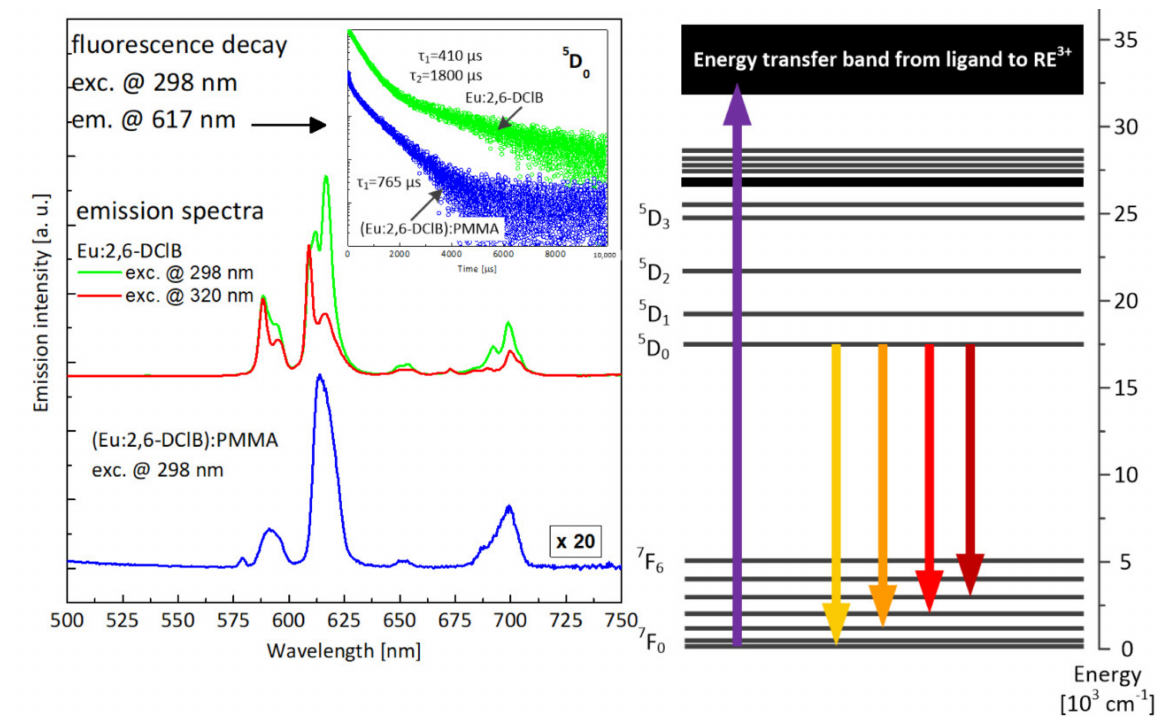
Figure 10. Comparison of luminescence spectra recorded for the Eu:2,6-DClB complex and the Eu2,6DClB/PMMA polymer composite (fluorescence decays for both materials shown in inset) together with the attribution of luminescent transition within the energy-level structure of the europium ion (on the right).